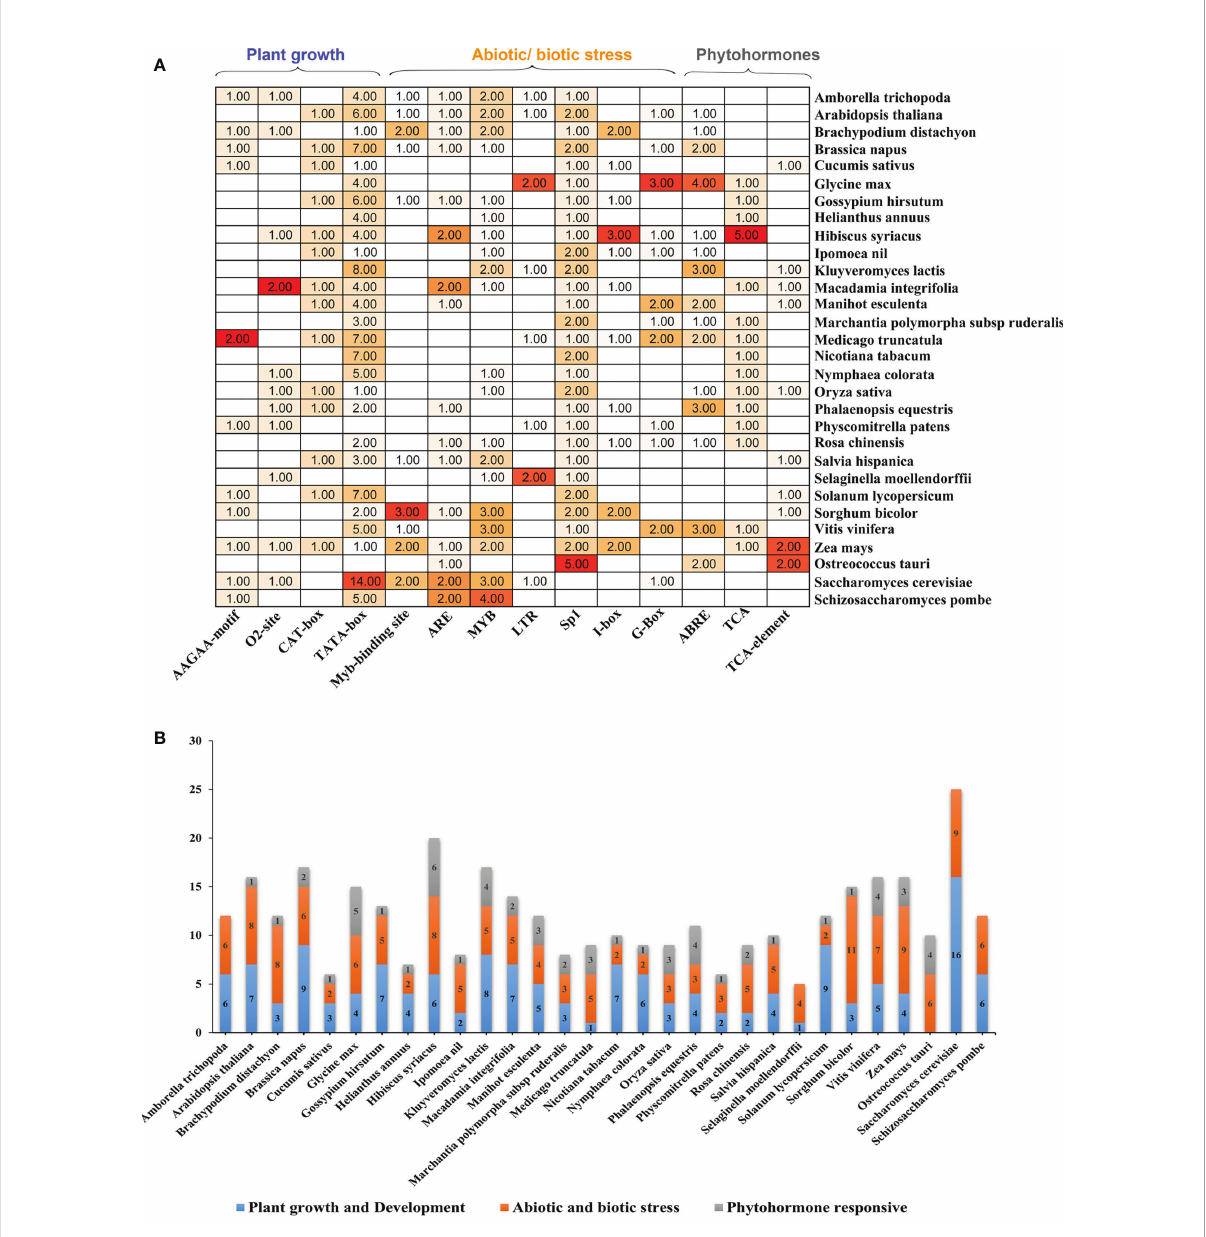
FIGURE 3 Cis -acting elements in ELP4 promoter of various plants and yeast. (A) Cis -acting elements with functional similarity on the upstream region of ELP4 genes are demonstrated by multiple colors. (B) In each category (plant growth development, abiotic/biotic stress, and phytohormone responsive), present cis -acting elements represent with different